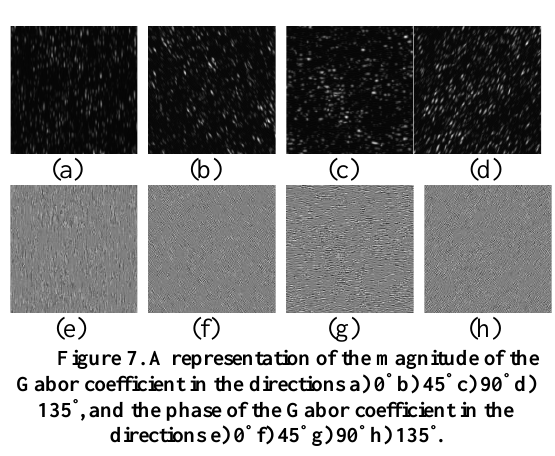
Figure 6. a) Tarom rice image b) Magnitude of the Gabor coefficient matrix c) Phase of the Gabor coefficient matrix.